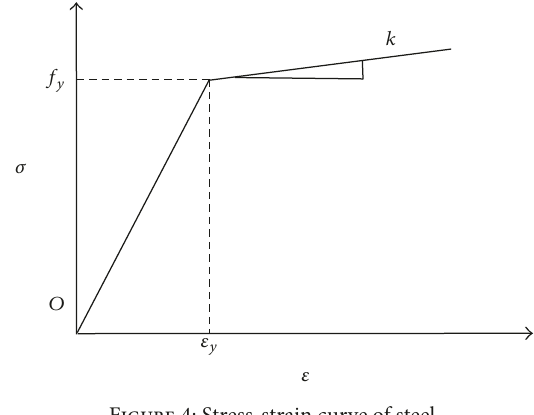
Figure 4: Stress-strain curve of steel.